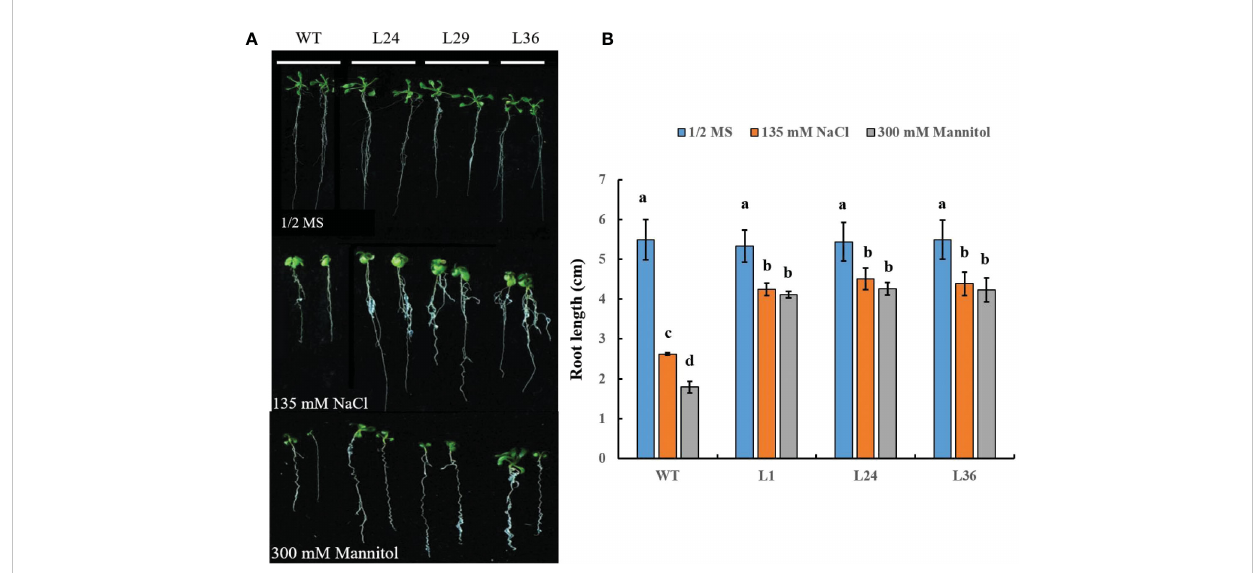
FIGURE 9 The effects of salt and mannitol stress on root length in Arabidopsis GhGT23 -overexpressing lines. (A) Root images from plants growing on 1/2 MS agar, 1/2 MS agar supplemented with 135 mM NaCl, and 1/2 MS agar supplemented with 300 mM mannitol. (B) Quanti fi cation of primary root lengths from plants growing on 1/2 MS agar with and without 135 mM NaCl and 300 mM mannitol. Each bar represents the average of three experiments with 24 plants used in each experiment. Error bars indicate standard deviation and different letters indicate signi fi cant differences (p < 0.05) which were determined using ANOVA, followed by Duncan ’ s multiple comparison test. Each data point is the average of three experiments, with each experiment consisting of 48 plants.